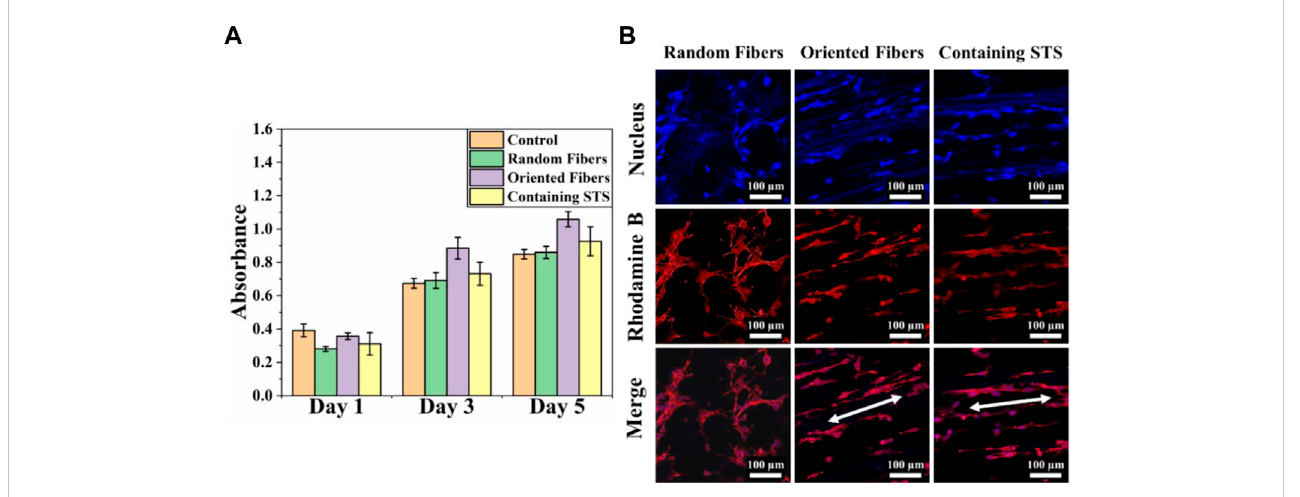
FIGURE 6 Cytotoxicity analysis of fi ber membranes. (A) Cell compatibility of 3T3 on random- fi ber membranes, oriented- fi ber membranes, and oriented- fi ber membranes containing STS (N = 3). (B) Laser scanning confocal microscopy of 3T3 on random- fi ber membranes, oriented- fi ber membranes, and oriented- fi ber membranes containing STS.